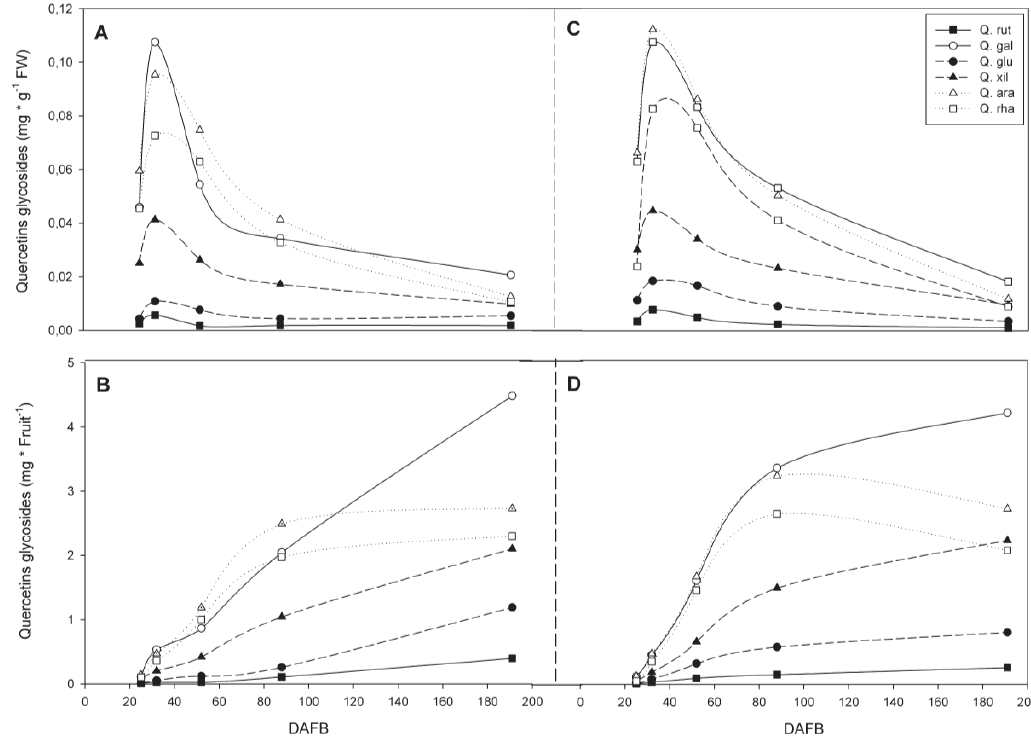
Fig. 2: Evolution of quercetins glycosides concentration and content in whole fruit from apple cv Fuji, from conventional (A and B) and organic (C and D) orchards, in different stages of development, during 2009/2010 season. Curves end at harvest. Q.rut, rutinoside; Q.gal, galactoside; Q. glu, glucoside; Q. xil, xyloside; Q. ara, arabinoside; Q.rha, rhamnoside.